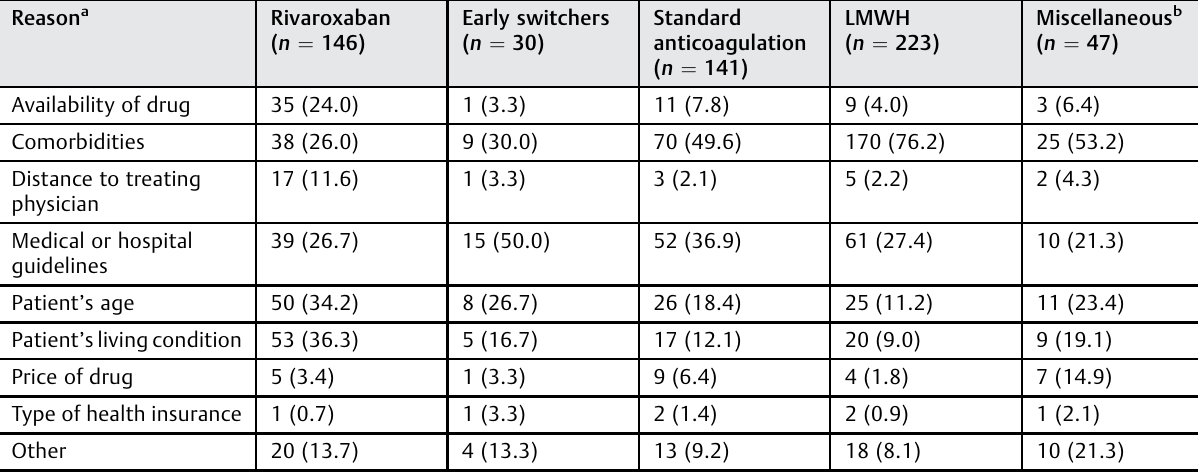
Table 3 Reason for choice of initial VTE treatment in patients with cancer